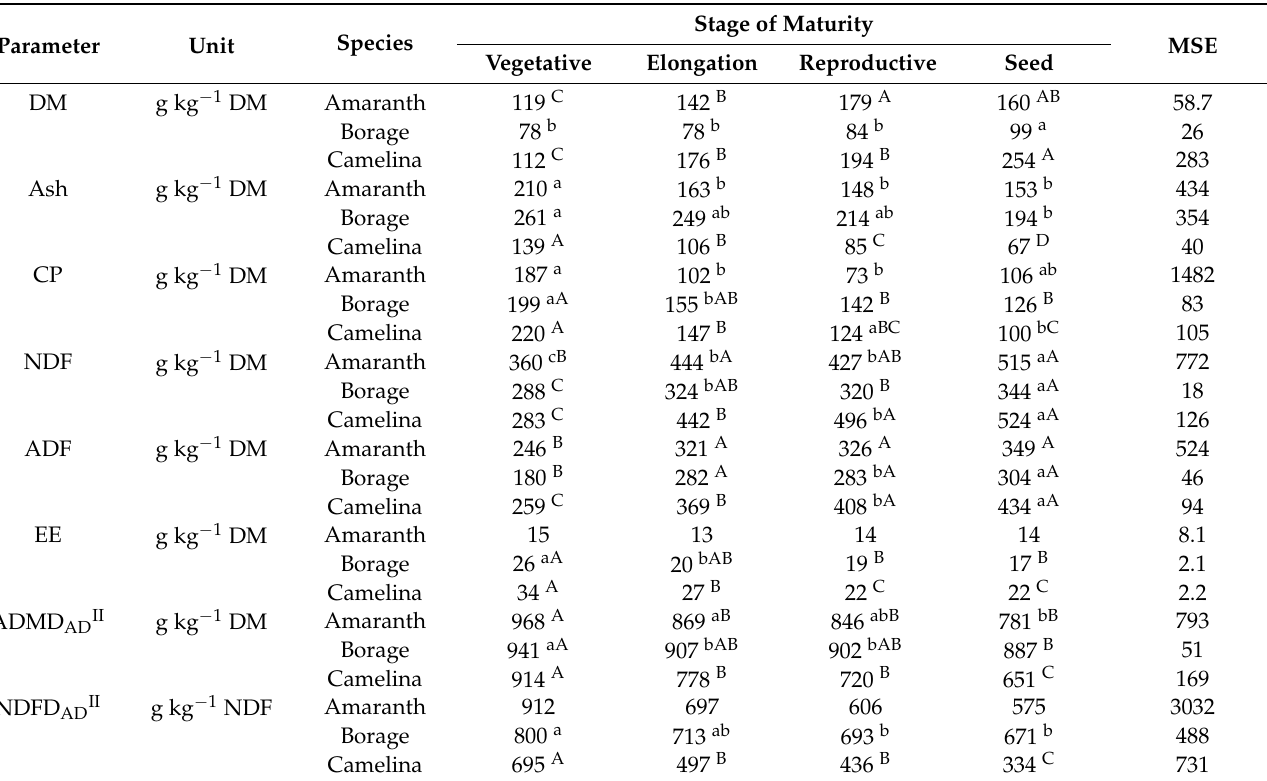
Table 3. Lsmean and mean square of error (MSE) for the measured parameters at the vegetative, elongation, reproductive, and seed stages (Amaranth DFE = 10; Borage DFE = 6; Camelina DFE =